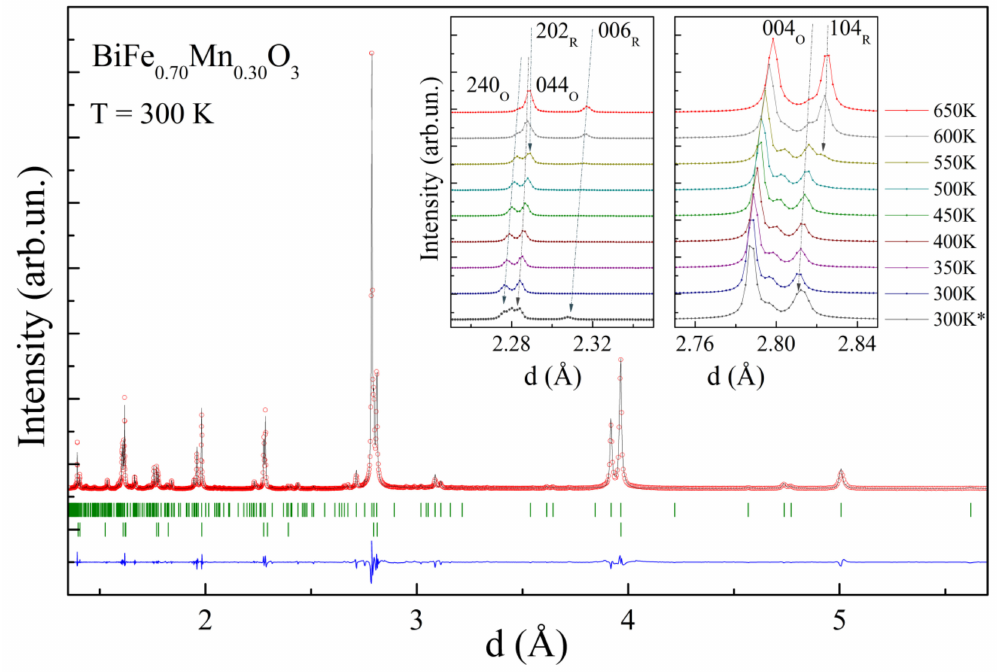
Figure 1. Synchrotron diffraction pattern recorded for compound BiFe 0.7 Mn 0.3 O 3 at room tempera- ture and calculated using the two-phase model (upper ticks—the orthorhombic phase). The insets show temperature changes of the reflections ascribed to the R - and O -phases (the pattern marked as 300 K* denotes the data obtained for the annealed